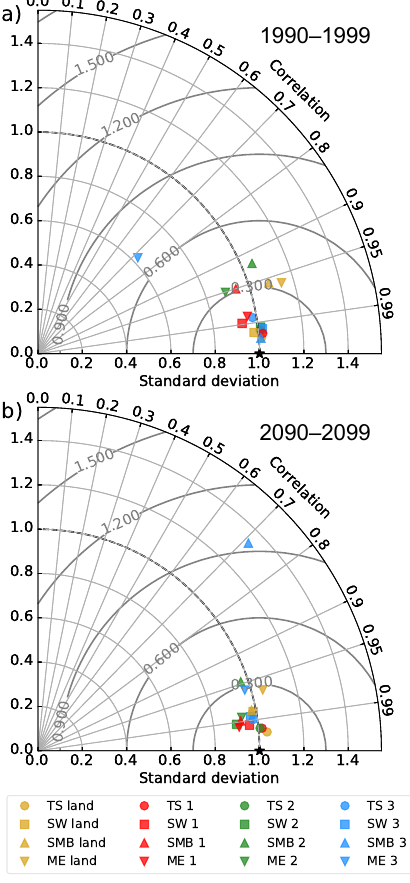
Figure 9. Taylor diagram of normalised surface temperature (TS), net shortwave radiation (SW), surface mass balance (SMB), and surface melt (ME) averaged over the whole Greenland ice sheet (as in Fig. 5 and 6) for the historical period 1990–1999 (a) and for the RCP8.5 scenario, years 2090–2099 (b) . The black star denotes the reference field, which has (per definition) a standard deviation and a correlation coefficient of